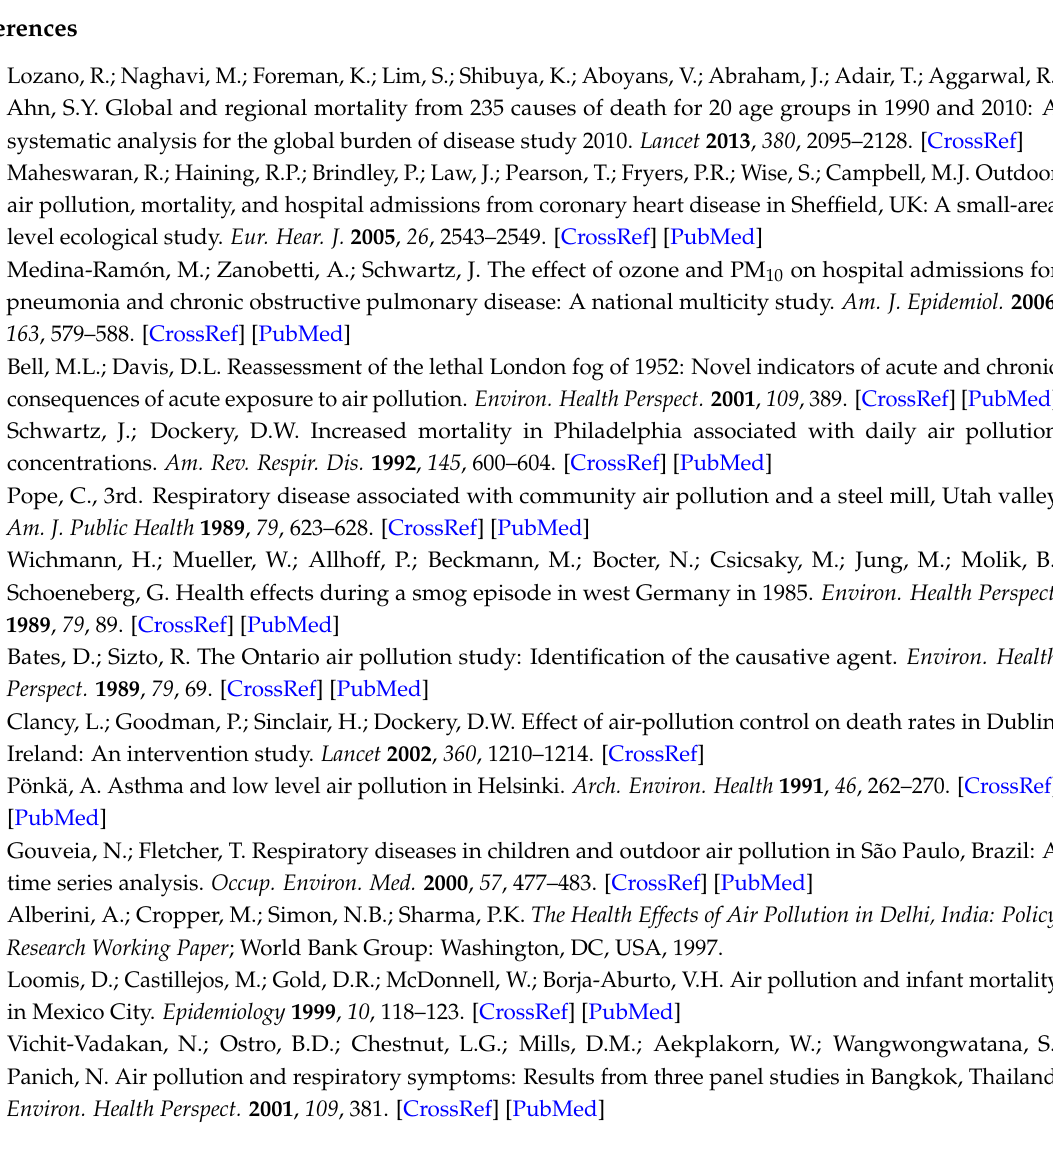
Figure A1. Smooth function curves of relative humidity and temperature: ( a ) relative humidity; ( b ) temperature.